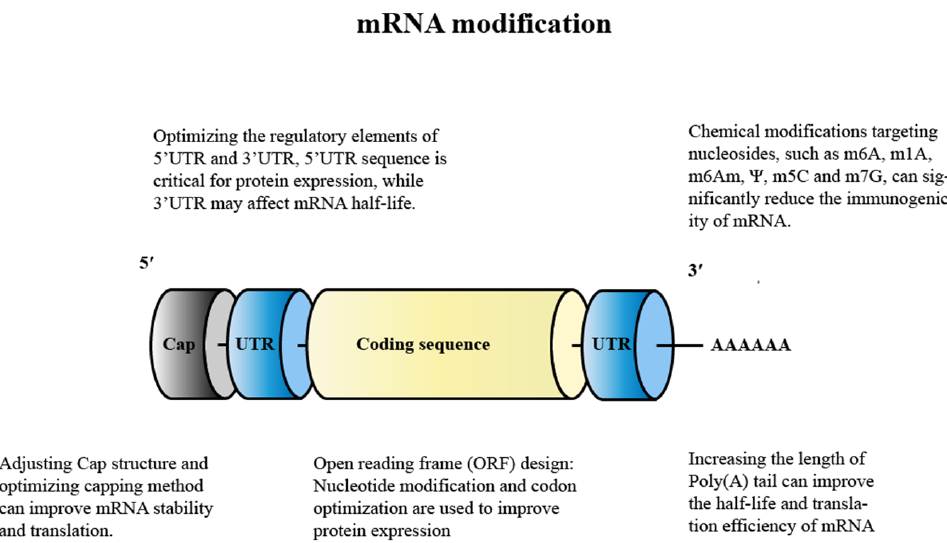
Figure 4. Principles and methods of modifying mRNA. Reprinted with permission from Ref. [73]. Copyright © 2021 Elsevier Ltd.